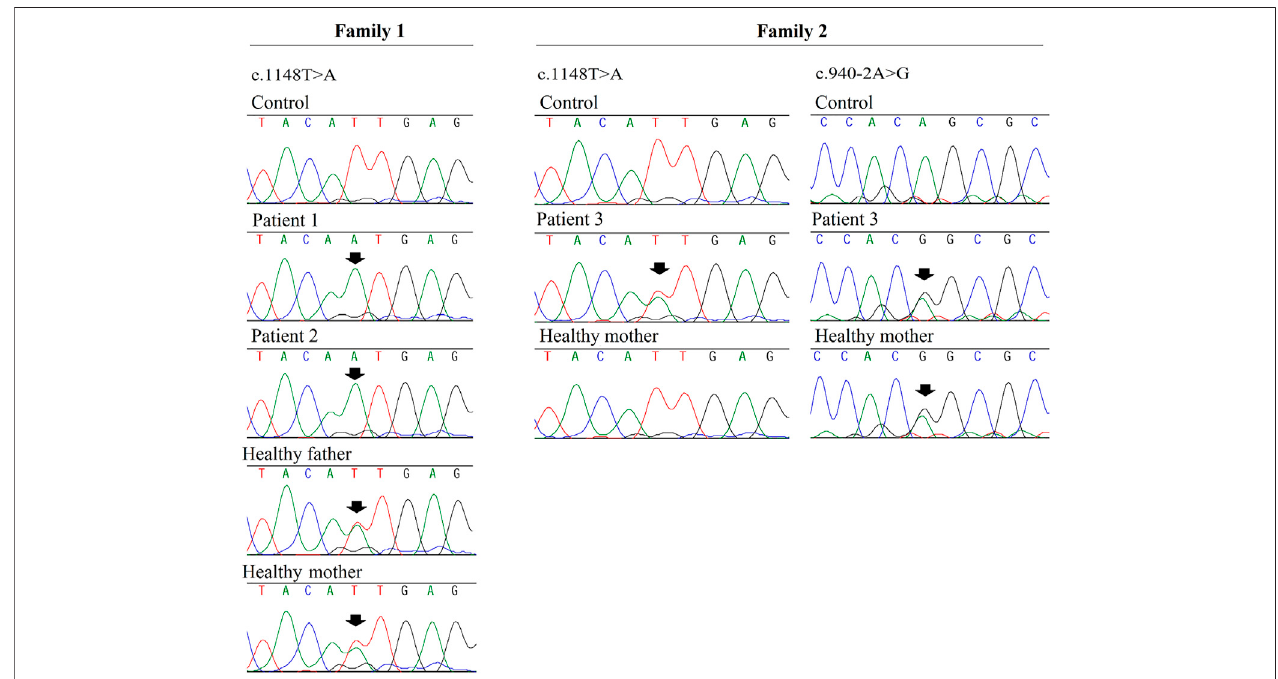
FIGURE 2 | Fragments of Sanger sequencing chromatograms are shown for VPS33B gene. The black arrows indicate the variants positions. Patients 1 and 2 (siblings)are homozygous for thec.1148T > A variant and theirparentsare heterozygous; patient 3iscompound heterozygous forvariants c.1148T > Aand c.940-2A > G (which was inherited from the proband ’ s mother). DNA sample from patient 3 ’ s father was not